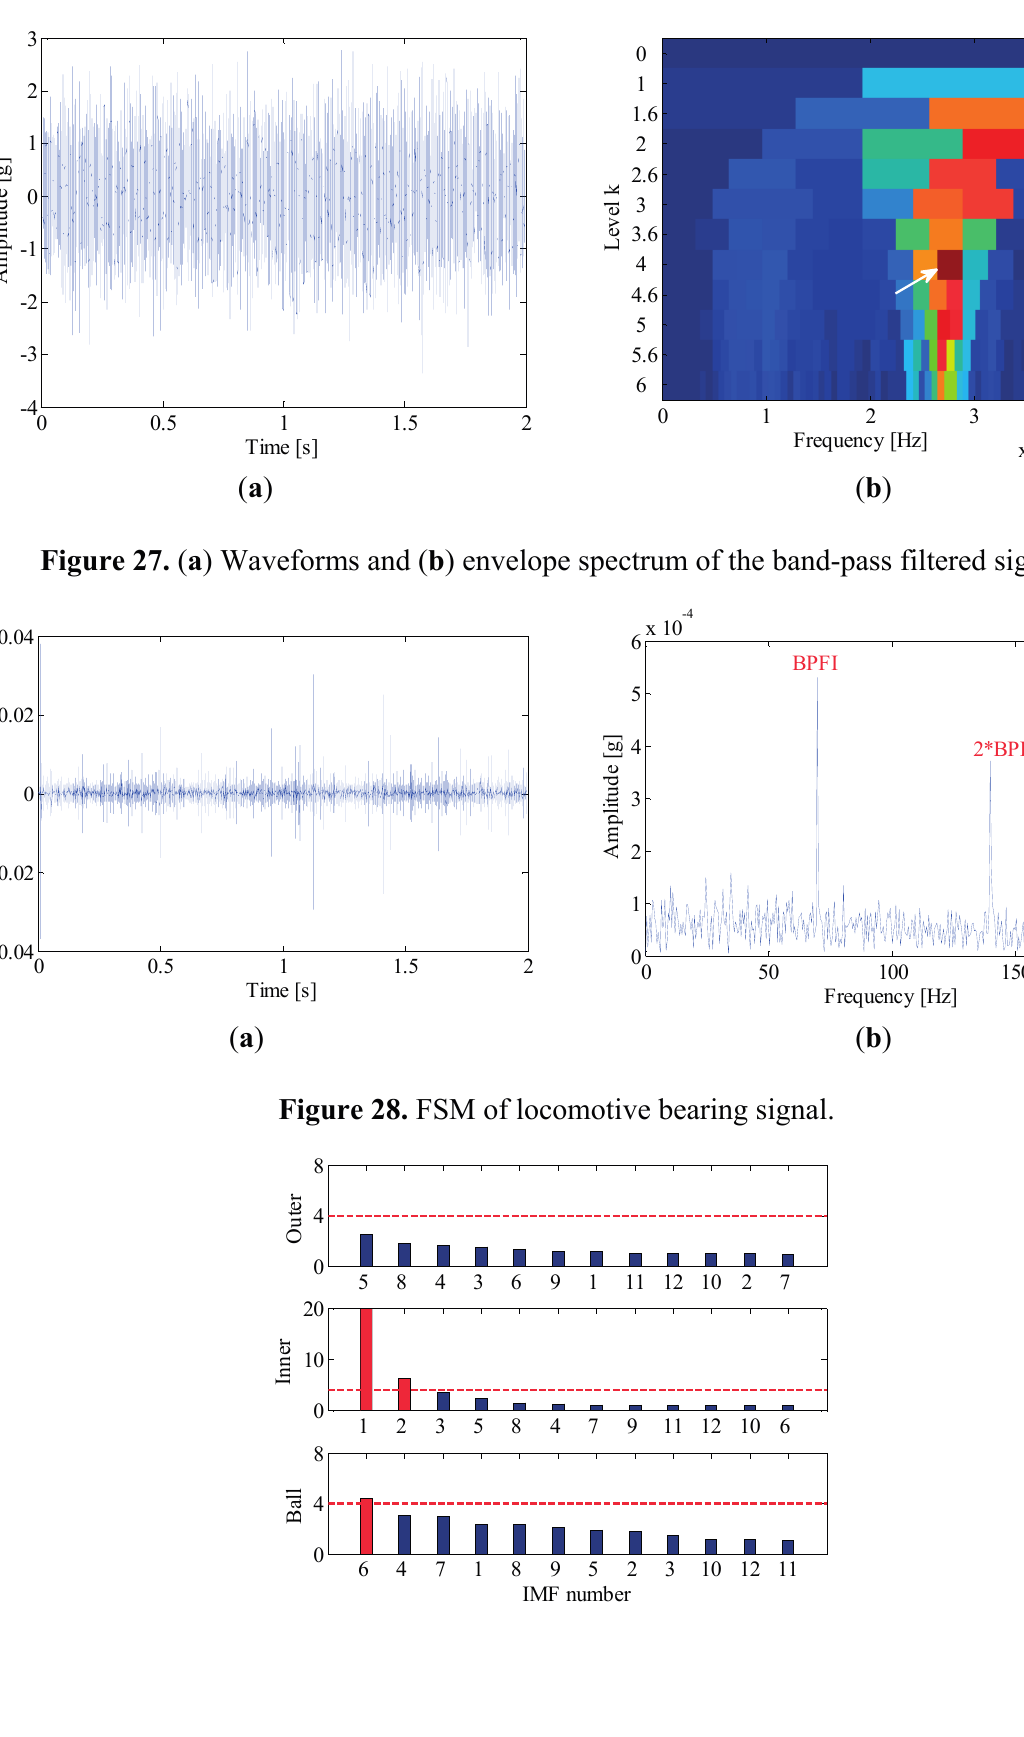
Figure 26. ( a ) Waveform and ( b ) kurtogram of the bearing signal.